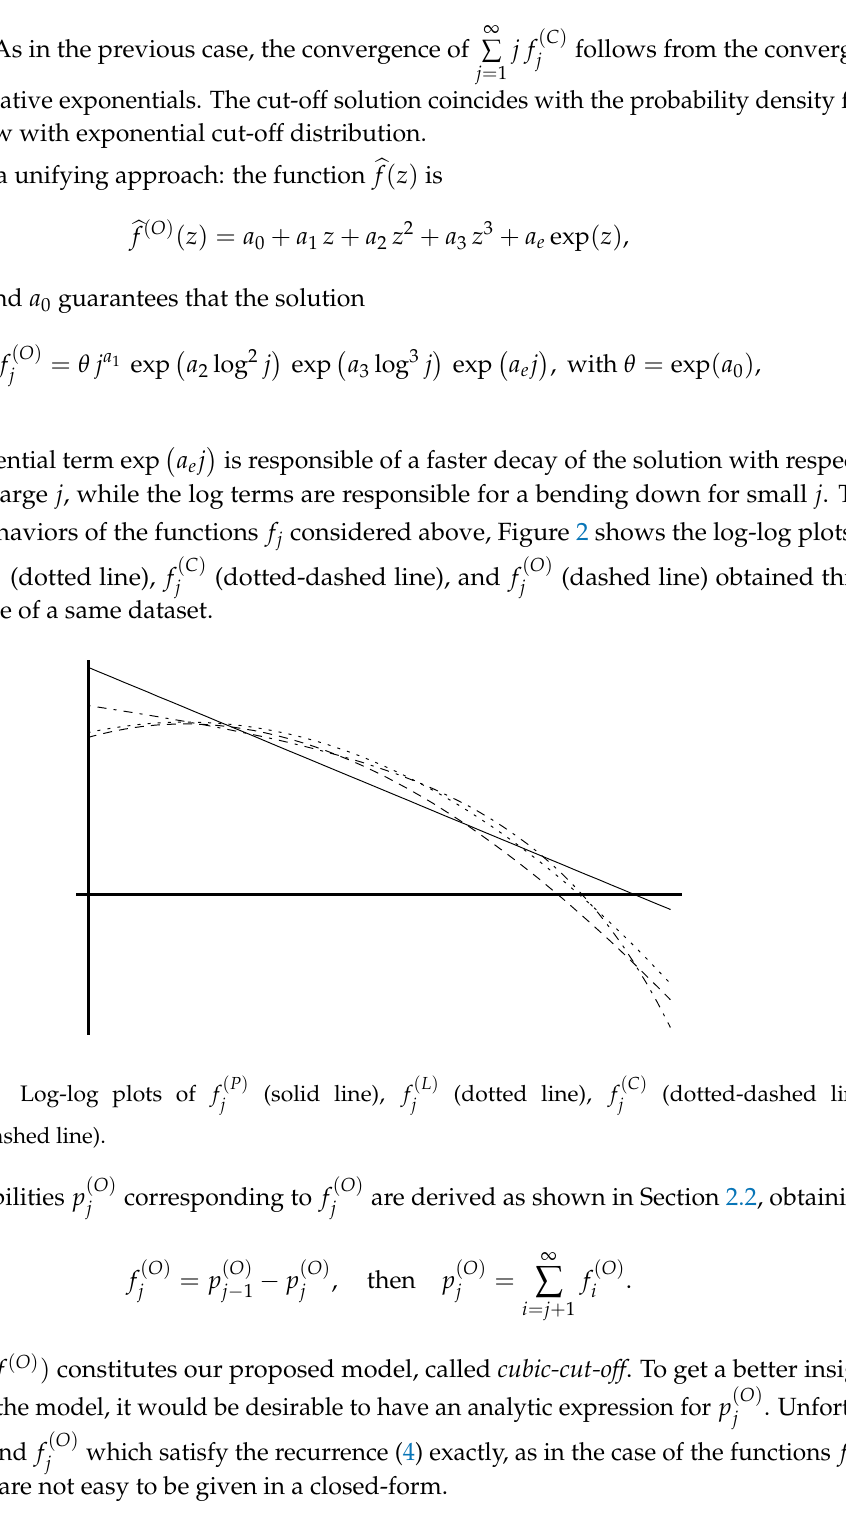
( P ) (solid line), f j